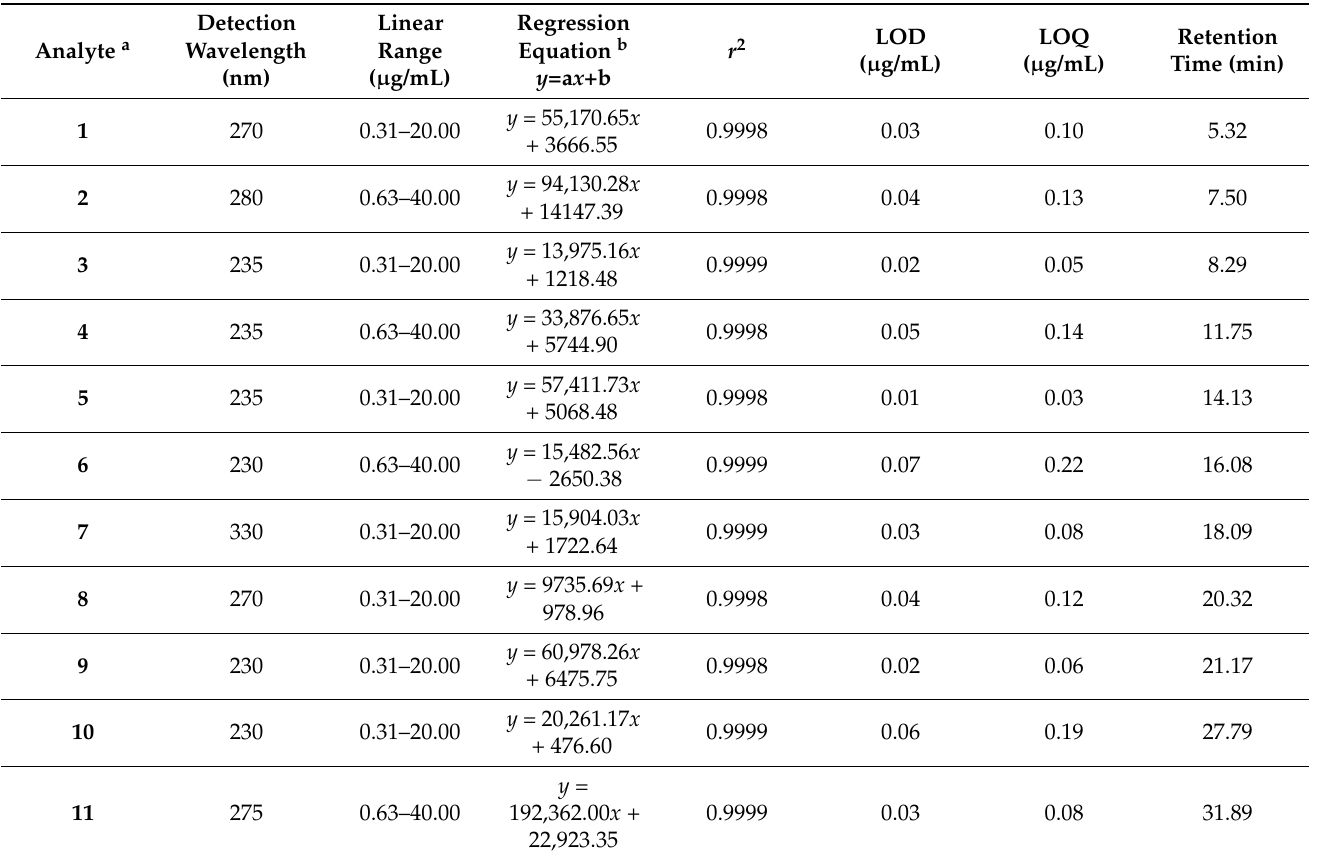
Table 2. Detection wavelength, linear range, regression equation, r 2 , LOD, LOQ, and retention time of each analyte for a simultaneous determination ( n =